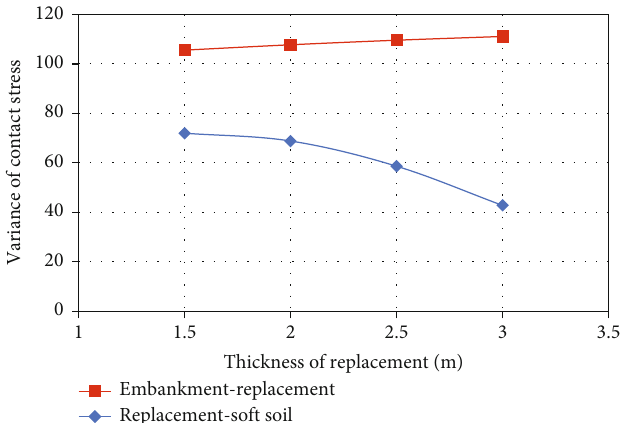
Figure 11: The variance of embankment-replacement and replacement-soft soil contact stresses with the increasing replacement